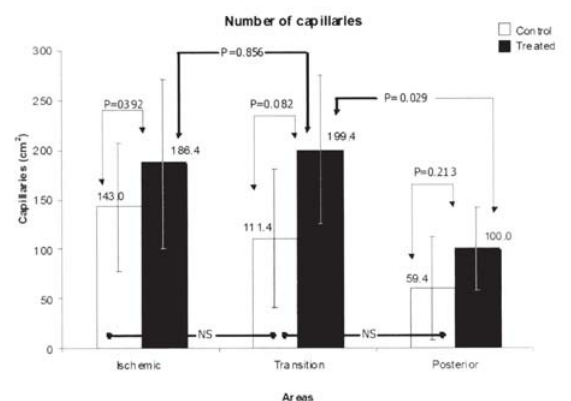
Fig. 3 - Comparison between the number of capillaries/cm 2 of area in control and treated groups. NS, non significant. Student’s t test between each two samples, for expression of differences between areas and groups